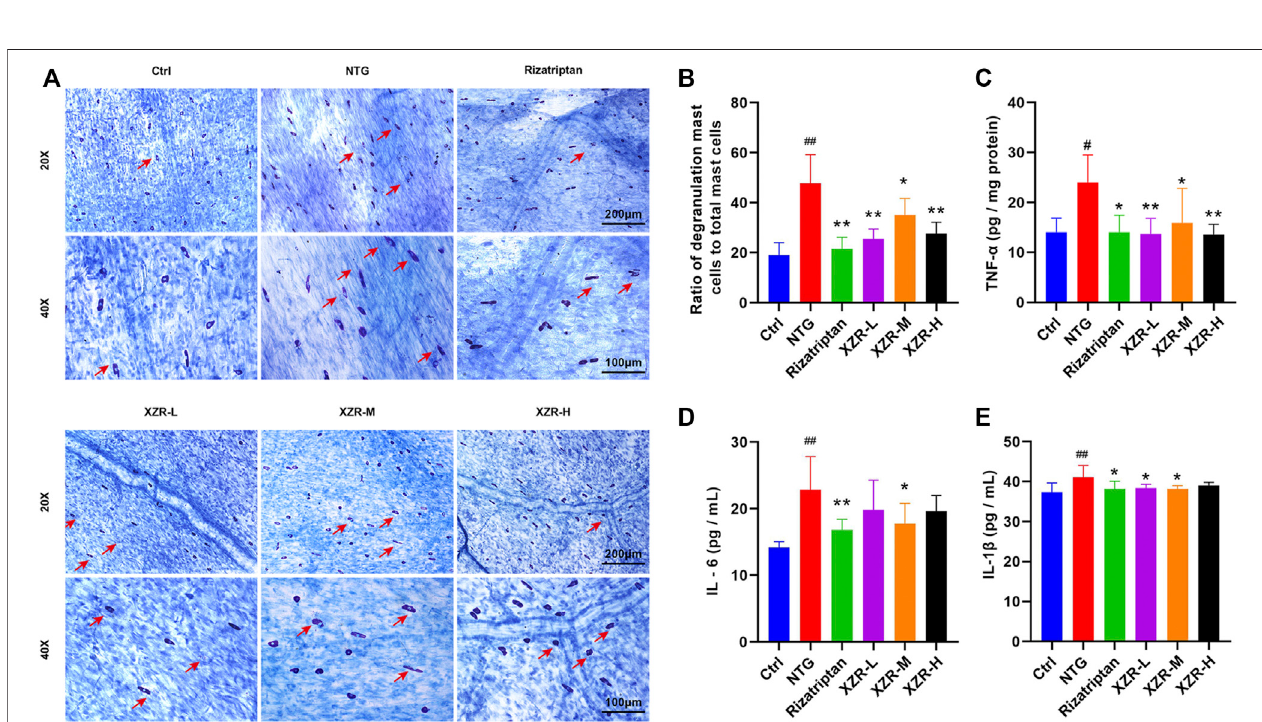
FIGURE 4 | XZR reduced the in fl ammation of rats with NTG-induced migraine. (A) Toluidine blue staining of mast cells in the dura (original magni fi cation ×20 and ×40). Scale bars = 200 μ m (×20) and 100 μ m (×40). The arrow indicates degranulated mast cells. (B) Ratio of degranulated mast cells to total mastcells. (C) TNF- α inbrainand (D) IL-6and (E) IL-1 β inserum.Dataarepresented asthemean±standarddeviation, n =5 – 6. # p < 0.05, ## p < 0.01versusthecontrol group, * p < 0.05, ** p < 0.01 versus the NTG group. XZR, Xiongshao Zhitong Recipe; NTG, nitroglycerin.